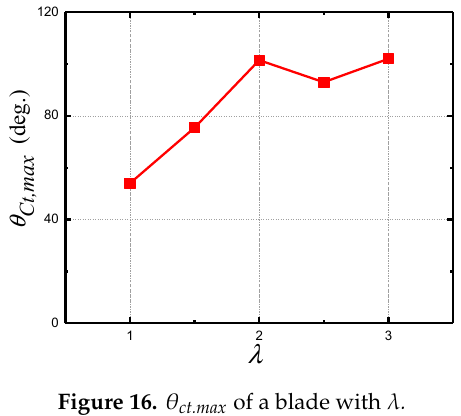
Figure 16. θ ct.max of a blade with λ .